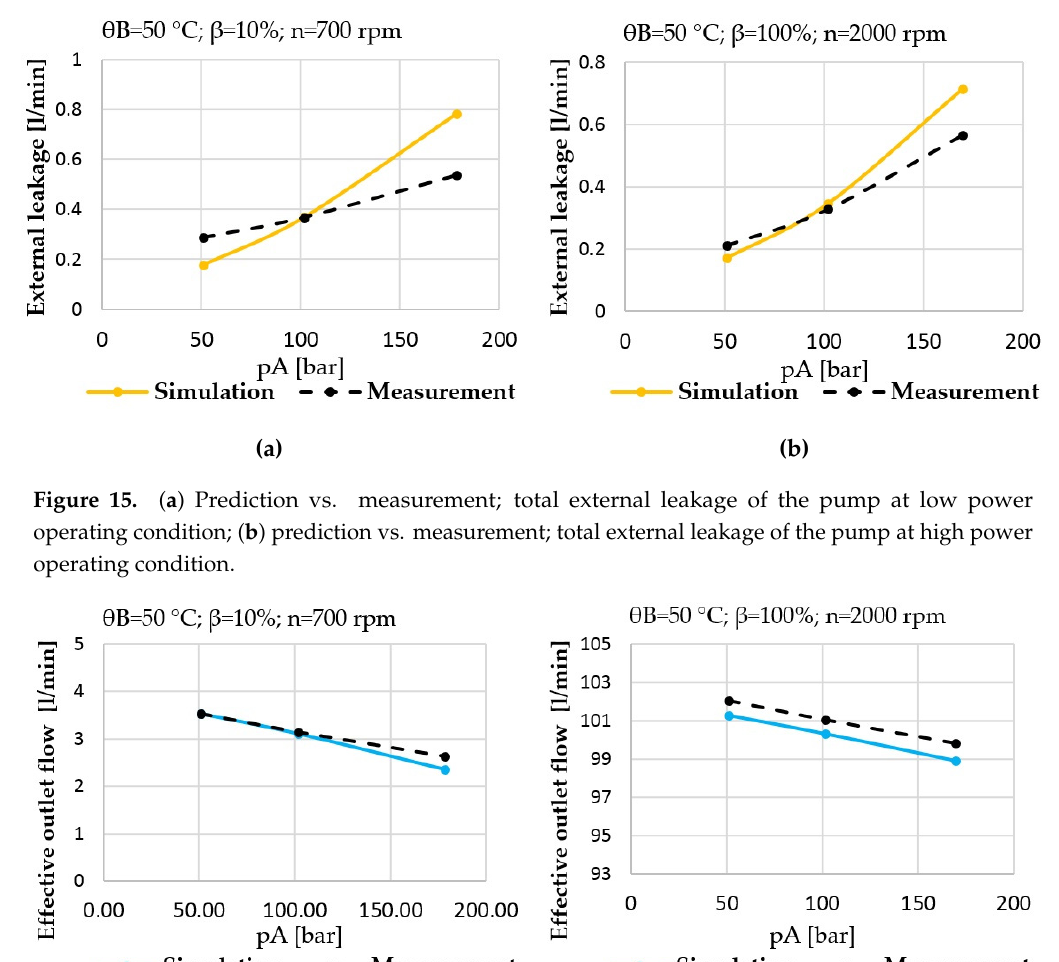
Figure 14. (a) Prediction of the leakage flow through the individual lubricating interfaces at low power operating condition; (b) prediction of the leakage flow through the individual lubricating interfaces at high power operating condition.